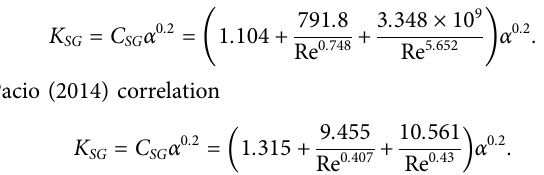
Based on experimental data of the spacer grid in the triangular rod bundle (Epiney et al., 2010; Pacio et al., 2014), the spacer grid resistance models are modi fi ed as the following correlations, in which n is equal to 0.2.Epiney (2010) correlation